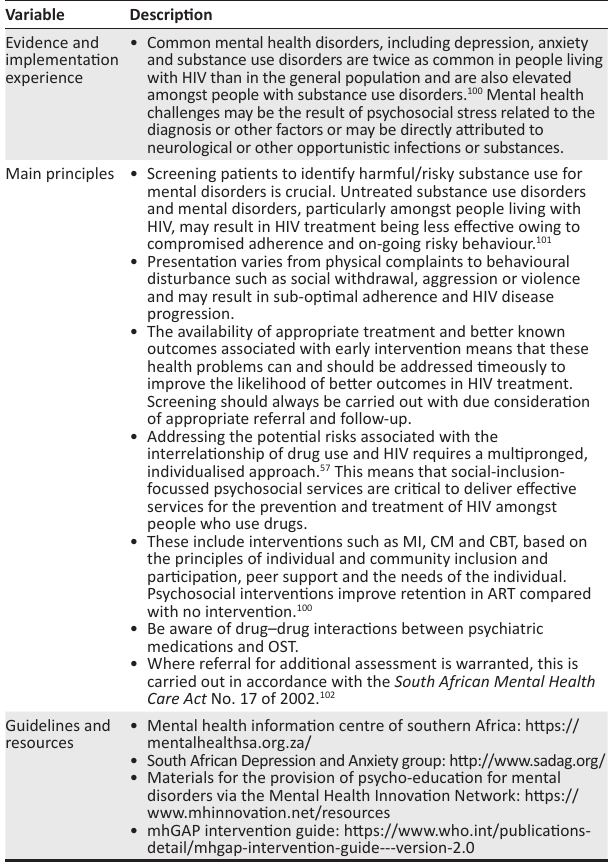
TABLE 23: Mental health